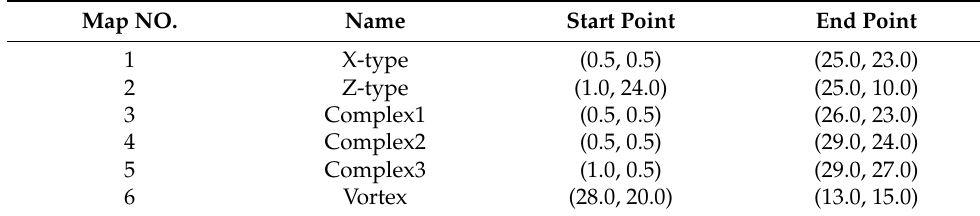
Table 3. Simulation environment